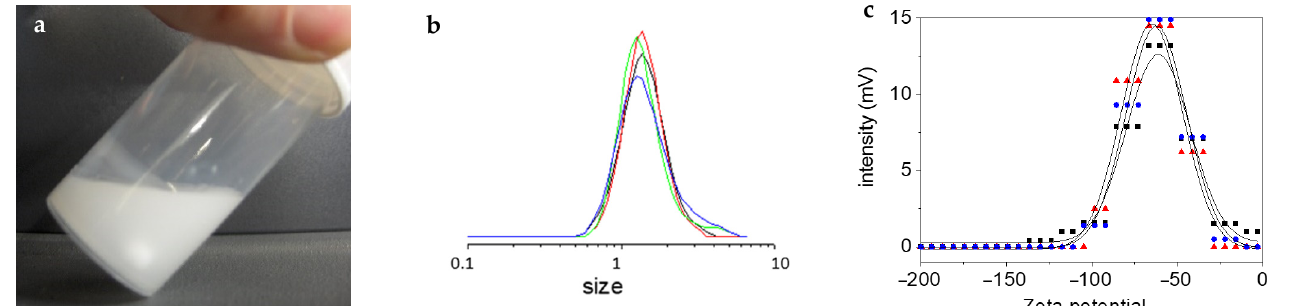
Figure 2. Colloidal state of D 3 suspension polymerization: ( a ) metastable emulsion, where polymer stains can finally be seen on the top of the wall; ( b ) average particle size at different times of reaction to highlight the emulsion stability (every 15 min in the following order: red, black, green, blue); ( c ) zeta potential of emulsion after 6 h on three different samples (average value of − 65 ± 15 mV).